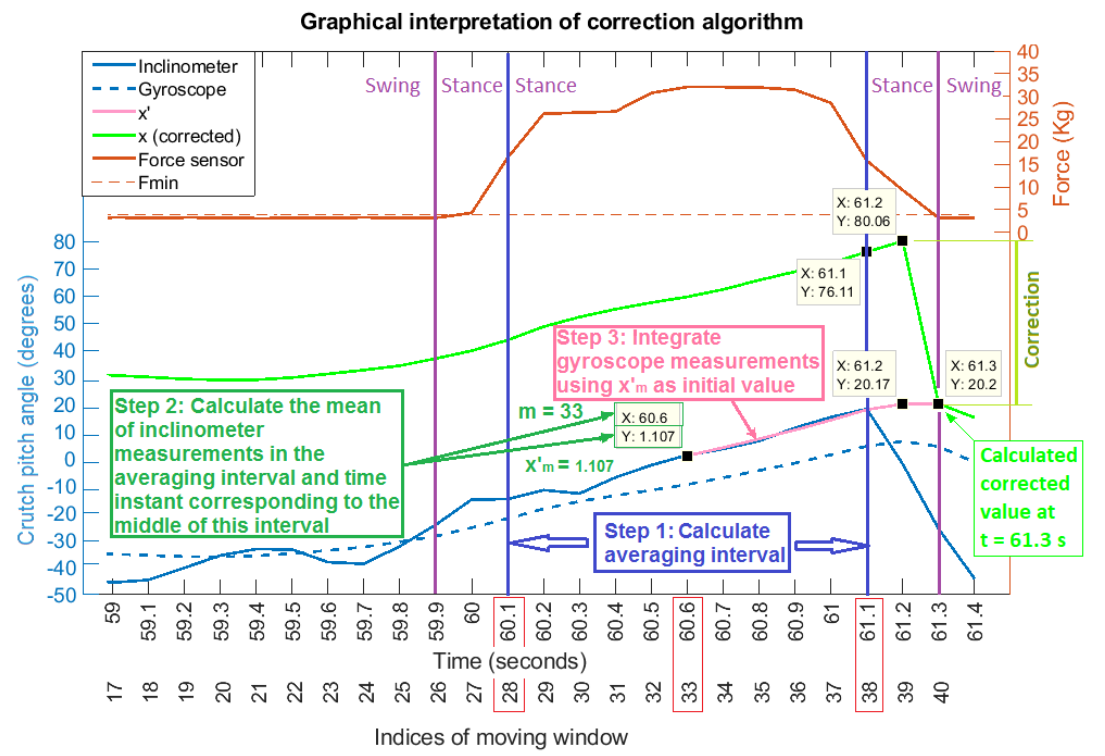
Figure 9. Graphical interpretation of the correction at the end of the stance phase. The continuous blue signal corresponds to the inclinometer’s measurements, the dashed blue signal to the integral of gyroscope measurements, the continuous red signal to the force measurements, the dashed red line to the selected force threshold, the light green signal to the outputs estimated by the algorithm at each time instant, and the pink signal to the past values estimated by the algorithm after applying the correction at the end of the stance phase. The plotted interval corresponds to a part of the first cycle after a turn.